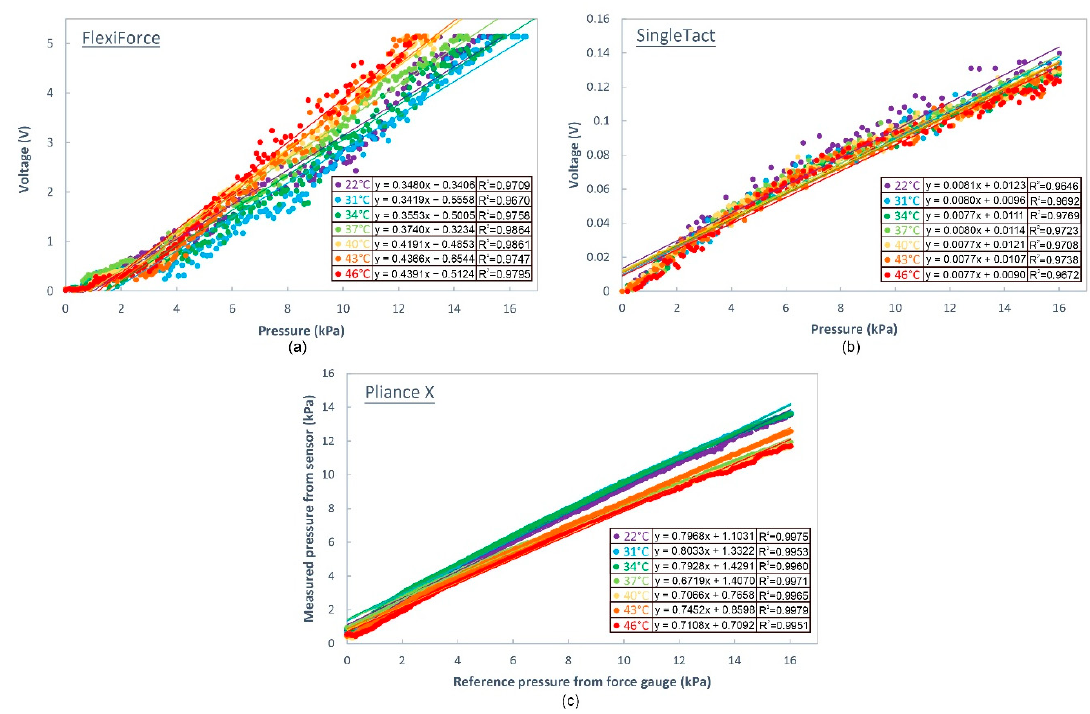
Figure 7. Calibration curves of different sensors measured on soft surface (silicone of 00-30 hardness) maintained at different temperatures: ( a ) FlexiForce sensor, ( b ) SingleTact sensor, and ( c ) Pliance X sensor.